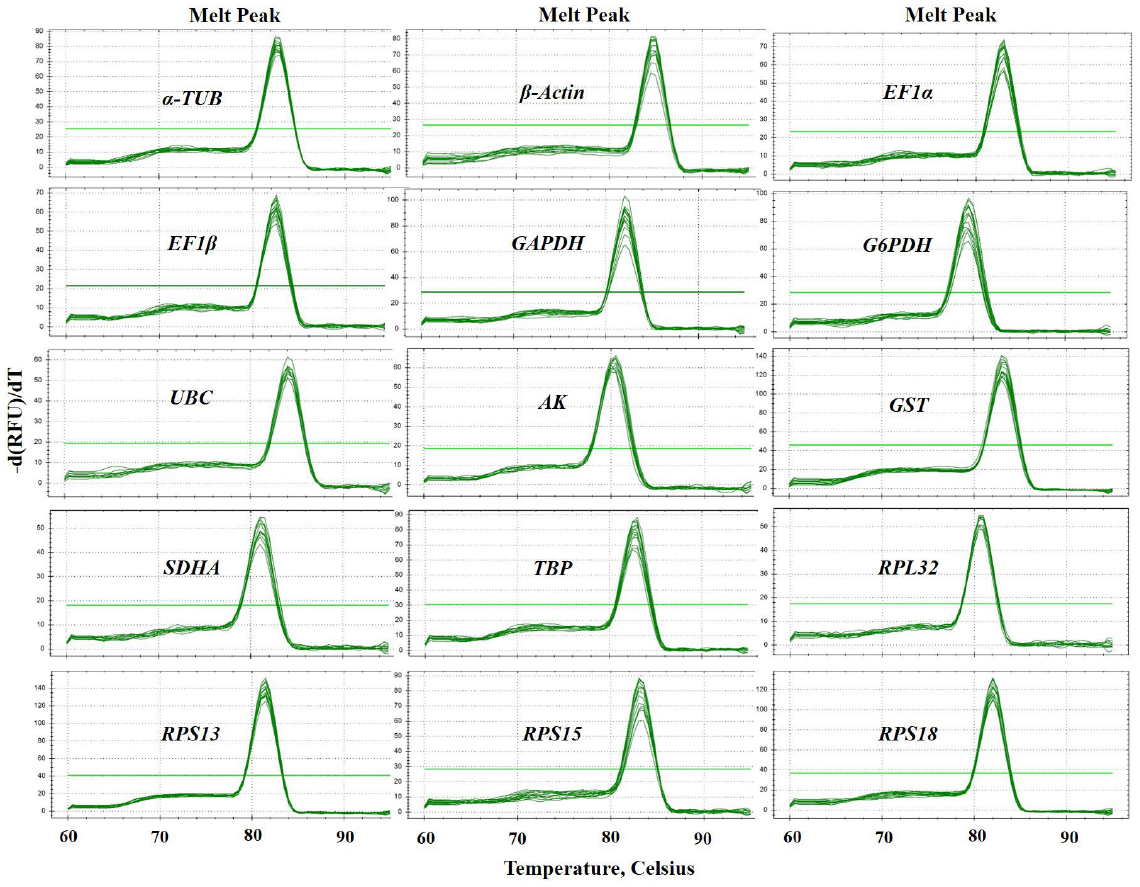
Figure 2. Specificity of primer pairs for qPCR amplification in N. asiatica . The melt peaks of primers for qPCR amplification of 15 candidate RGs, including α-TUB , β-Actin , EF1α , EF1β , GAPDH , G6PDH , UBC , AK , GST , SDHA , TBP , RPL32 , RPS13 , RPS15 and RPS18 .